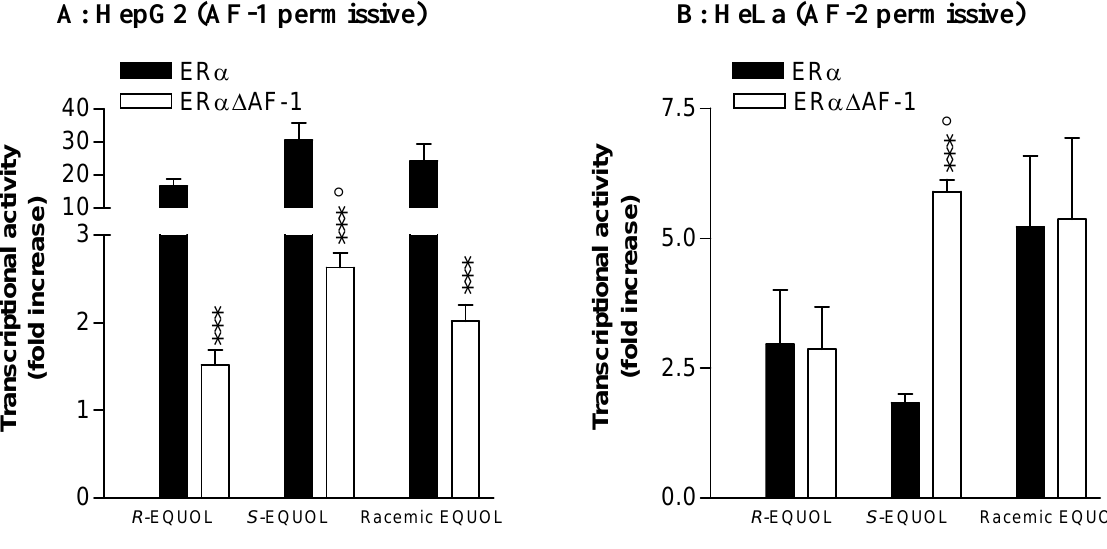
Figure 4. Transcriptional activation of ER  and ER  AF-1 by enantiomeric forms of equol in HepG2 (AF-1 permissive) and HeLa (AF-2 permissive) epithelial cells. The effects of R- and S- forms and racemic equol (10 µM) on ER  and ER  AF-1 transcriptional activities in HepG2 ( A ) and Hela ( B ) cell lines, respectively. Cells were co-transfected with ER  or ER  AF-1 and the ERE-TK-LUC. Data are expressed as reporter fold induction compared to control (Vehicle (V), EtOH 0.01%). Shown are means ± SEM of 2-5 independent experiments, each performed in triplicate. Comparisons between experimental conditions were performed as described in methods section. Statistical significance for comparison between ER constructs or between R - and S -equol is indicated by *** for p < 0.001 or by ° for p < 0.05,